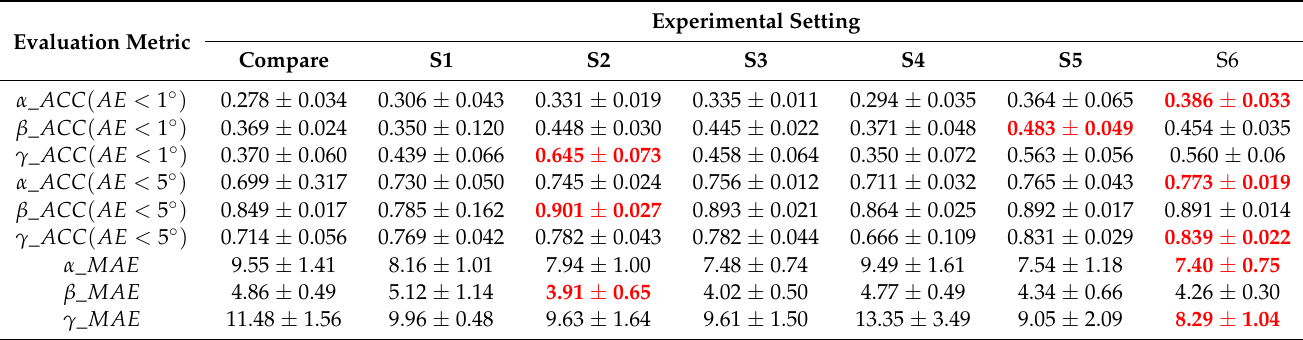
Table 7. Performance of different 3D prior information fusion module structures. The optimal results are tabulated in